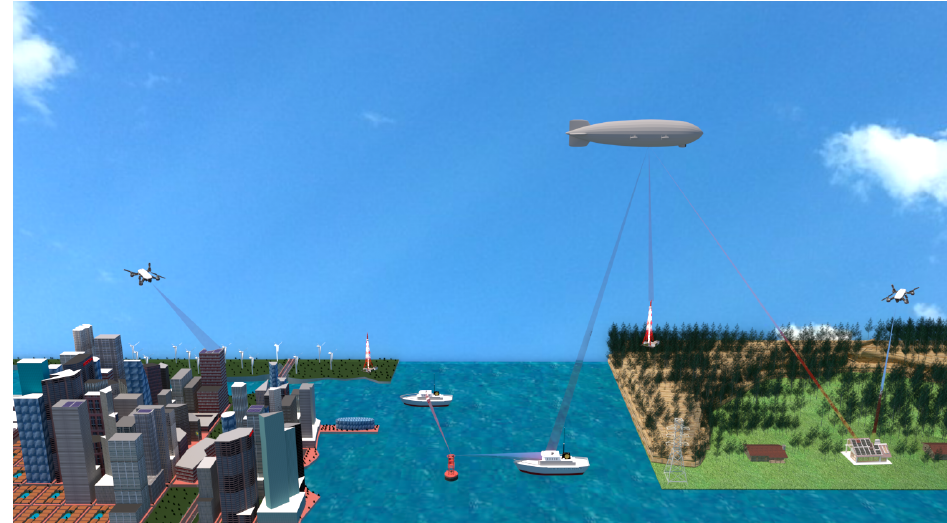
Figure 1. Illustration of a generic network architecture of self-powered devices.